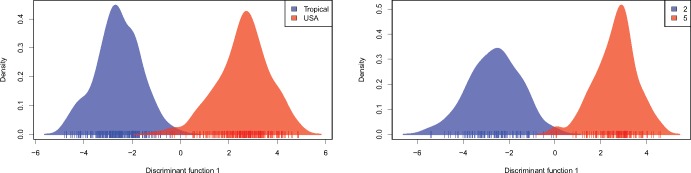
Discriminant analysis of principal components: One principal component separates the groups of trees in both cases. Left: tropical versus USA trees. Right: simulated birth–death trees.